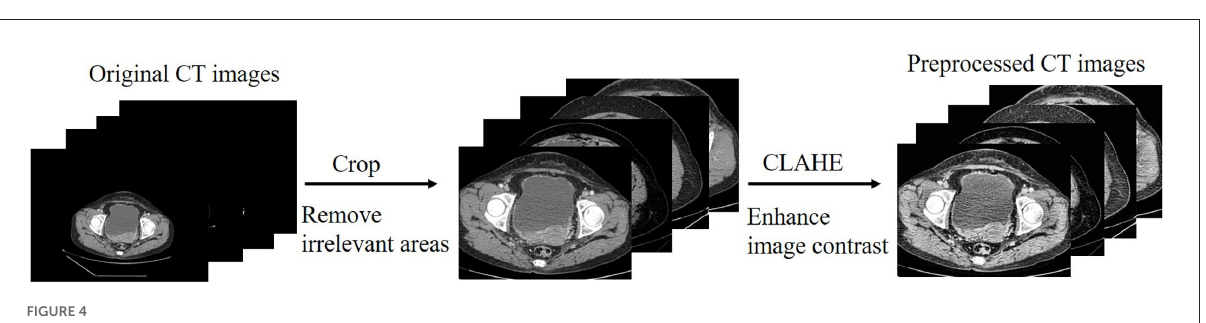
FIGURE4 The process of CT image preprocessing.